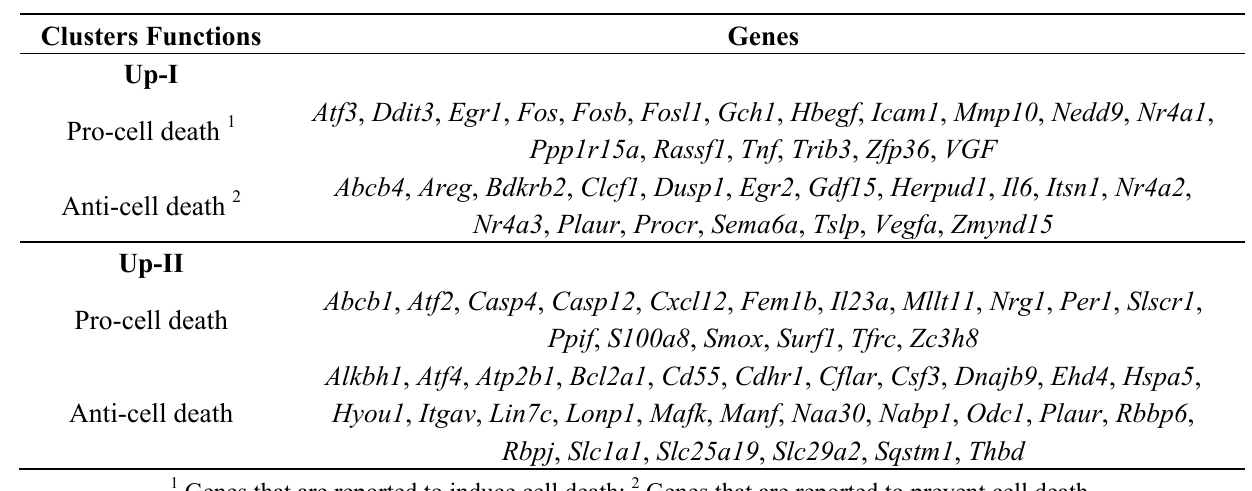
Table 1. The function of cell death-related genes in Up-I and Up-II